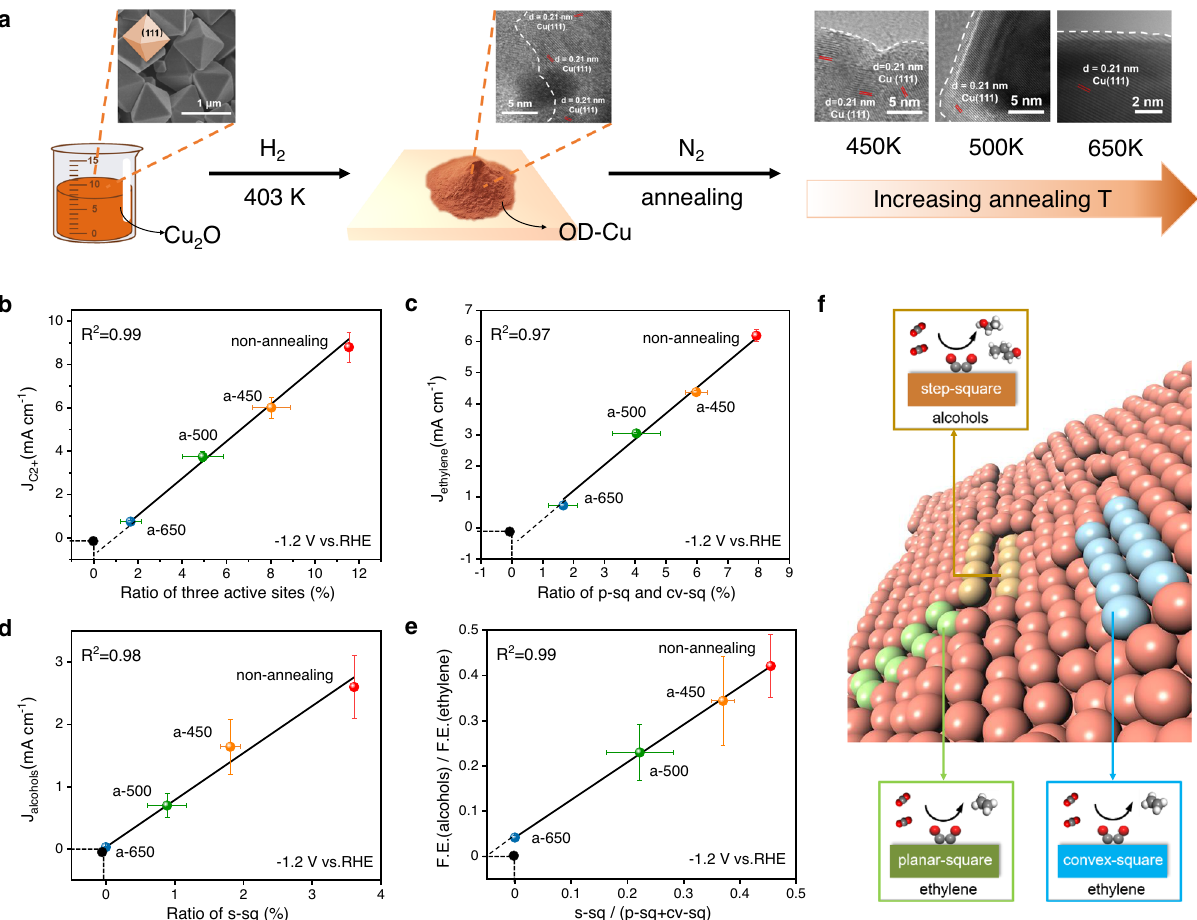
Fig. 4 Veri fi cation of active sites via thermal annealing process. a Schematic illustration of OD-Cu preparation and annealing process in experiment. The upper layer, TEM image of Cu 2 O, SEM images of OD-Cu, a-450, a-500, and a-650 from left to right. The white dotted lines indicate the rough particle surface. The correlation between the current density of b C 2 + products and the ratios of all three active sites c ethylene and the ratios of planar-square and convex-square sites d alcohols and the ratios of step-square sites. e Alcohols/ethylene ratios as the function of the ratios of step-square sites to the sum of planar-square and convex-square sites at − 1.2 V vs. RHE. f Proposed structure – activity relationship diagram on OD-Cu in CO 2 R. a-450, a-500, and a-650 represent annealing at 450, 500, and 650 K, respectively. The error bars represent the standard deviation from three independent